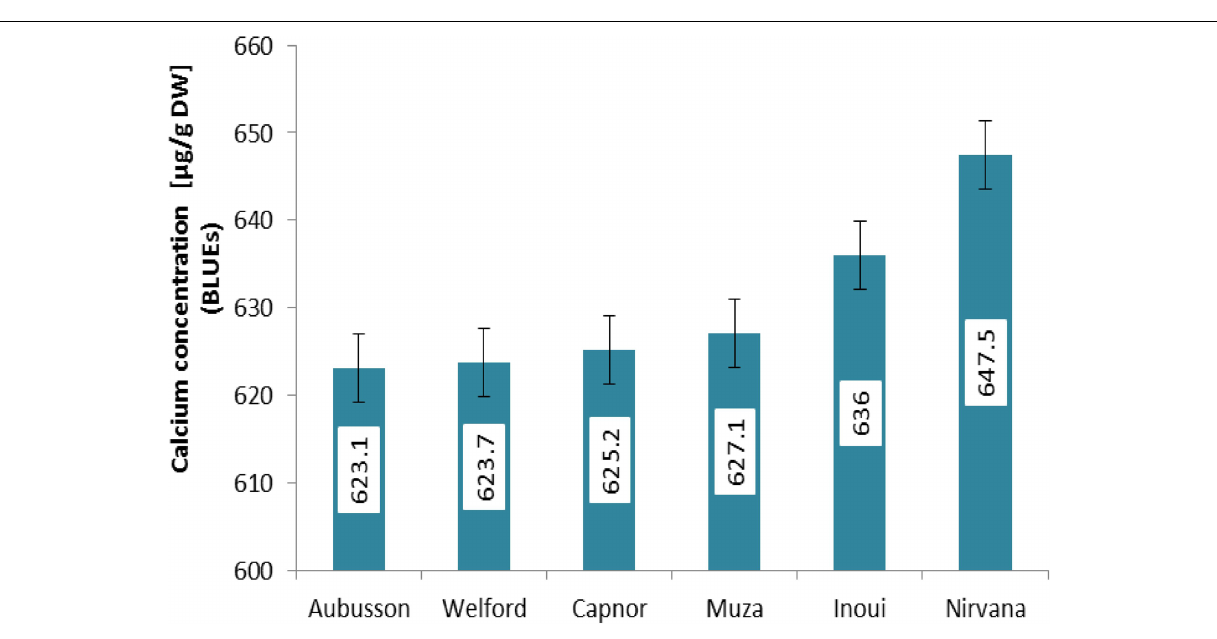
Frontiers in Plant Science |